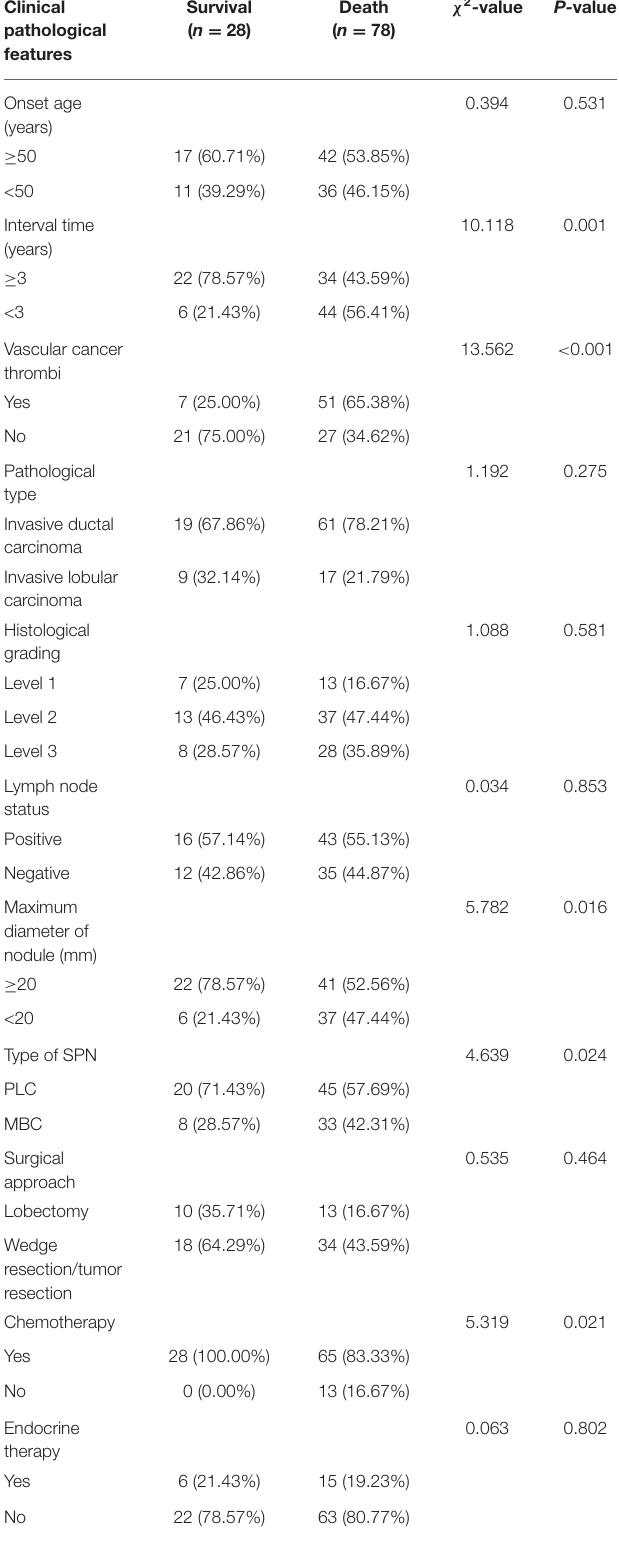
TABLE 3 | Univariate analysis of prognosis of patients with breast cancer combined with SPN ( n , %). Clinical pathological